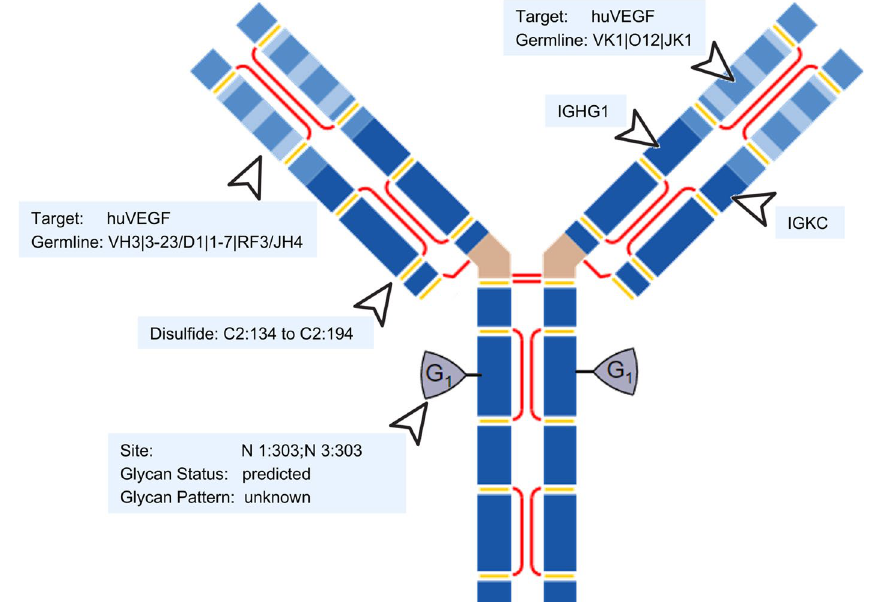
Fig. 5 An example of a IgG1 monoclonal antibody BioMap with an interactive display of sequence features and associated